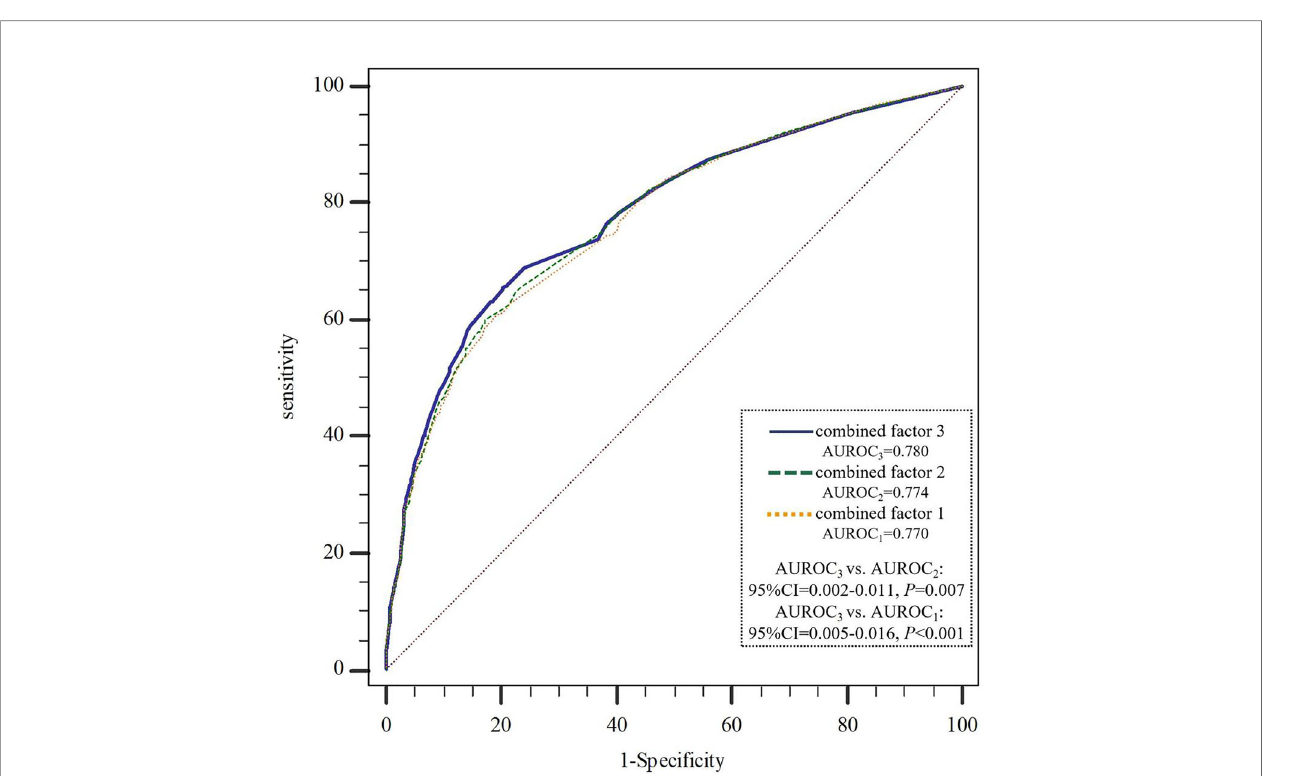
FIGURE 1 | AUROCs comparison of the three combined factors to assess NAFLD risk. NAFLD, non-alcoholic fatty liver disease; AUROC, area under the receiver operating curve. combined factor 1: a combination of age, visceral obesity, blood pressure, TG, HDL-C and ALT; combined factor 2: a combination of combined factor 1 and exercise time; combined factor 3: a combination of combined factor 2 and VDR